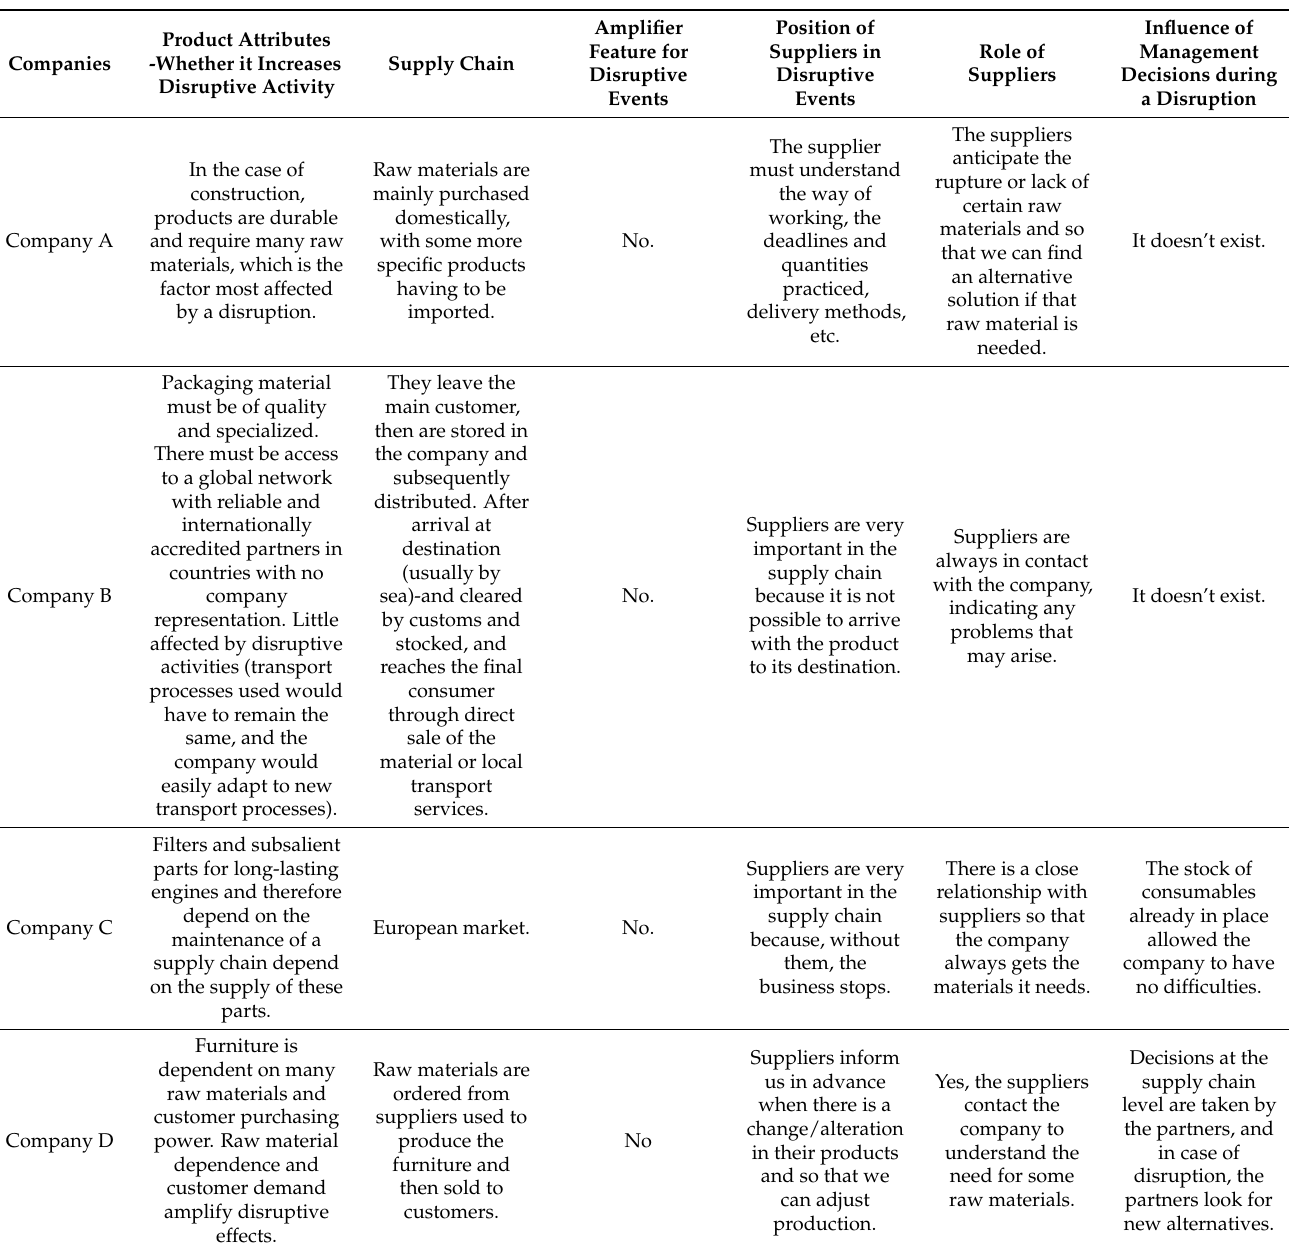
Table 3. Supply Chain Vulnerabilities